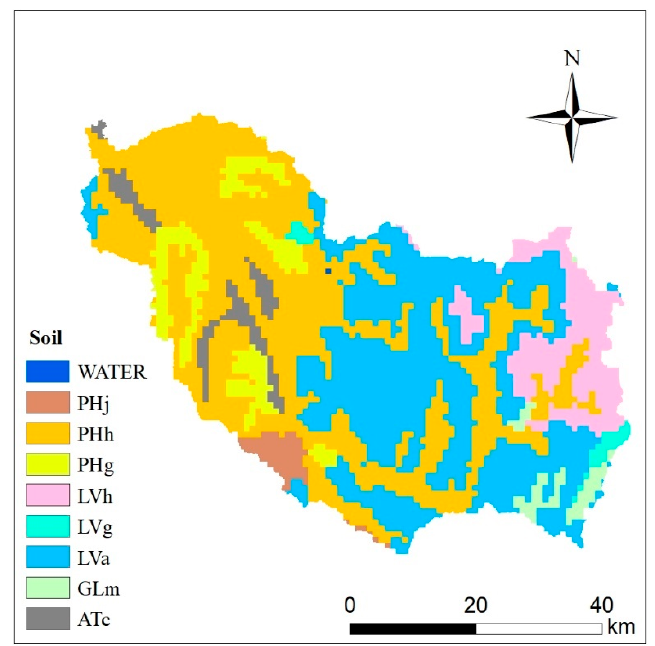
Figure 4. Map of soil type.